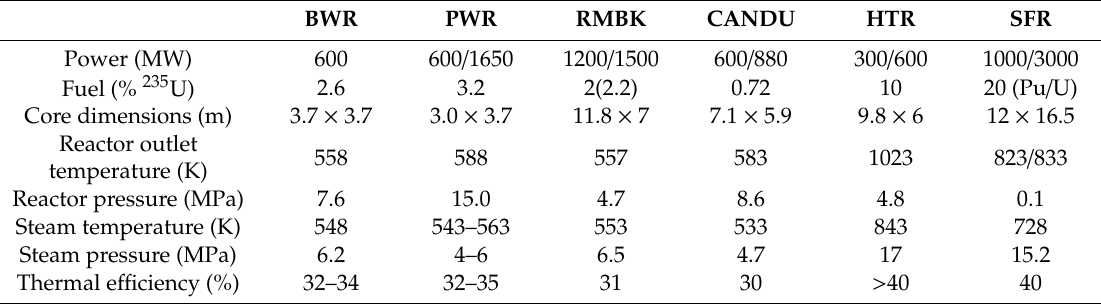
Table 1. Di ff erent types of nuclear technology-general